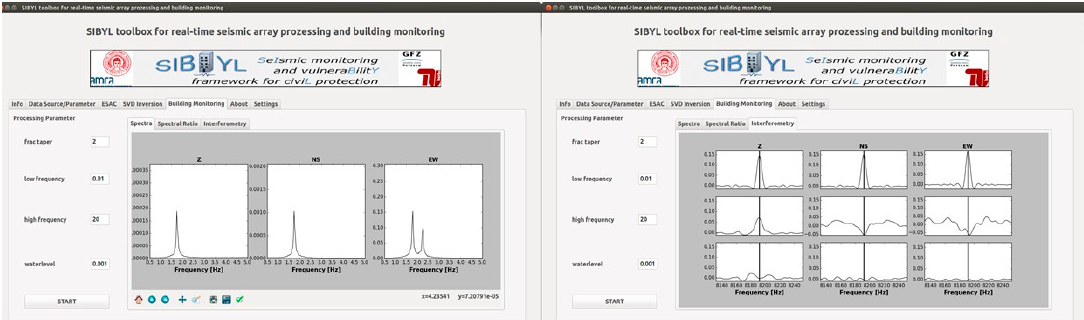
Figure 5. Example of output for short-time building measurements (note, this is the Graphical User Interface (GUI) developed for the SIBYL project for the case of the AHEPA hospital in Thessaloniki, Greece. The results may be viewed either on an embedded or external touchscreen). ( a ) Spectra computation to identify the resonance frequencies of the building. ( b ) Interferometry plot to evaluate the shear wave velocity inside the building.